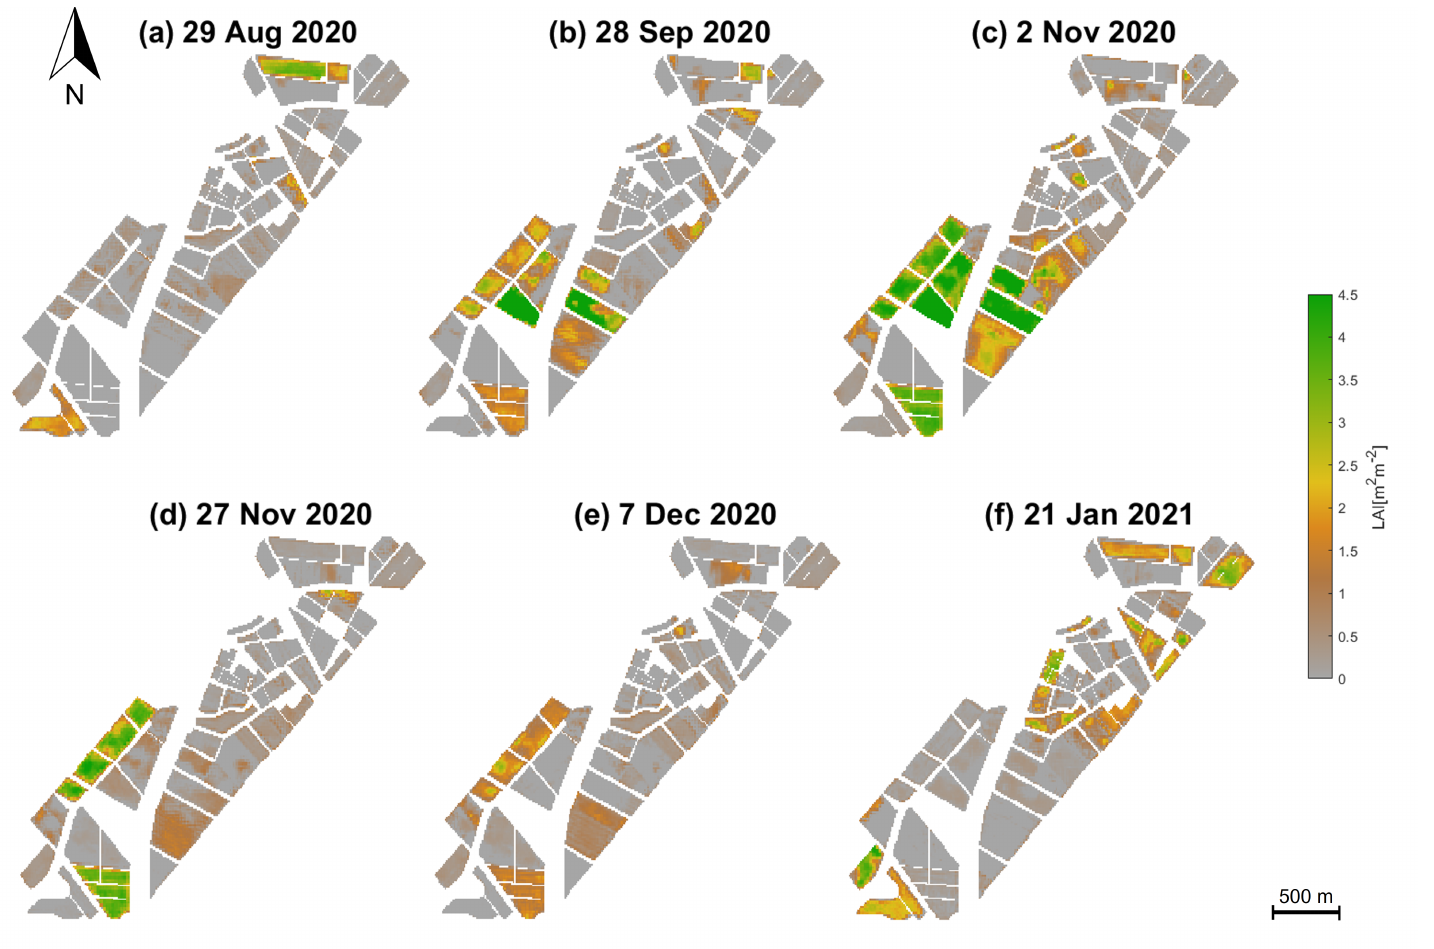
Figure 7. LAI [m 2 m − 2 ] of different crops in the study site, retrieved by the GPR model using simulated vegetation reflectance spectra, in-situ traits measurements and S2 surface multi-spectral reflectance data. Data obtained from BVCR wheat campaign 2020. ( a ) wheat tillering stage at 29 August 2020; ( b ) wheat booting